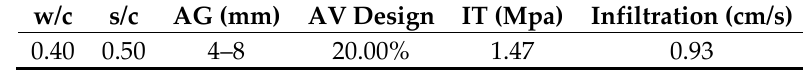
Table 4. Optimal proportions for a PC